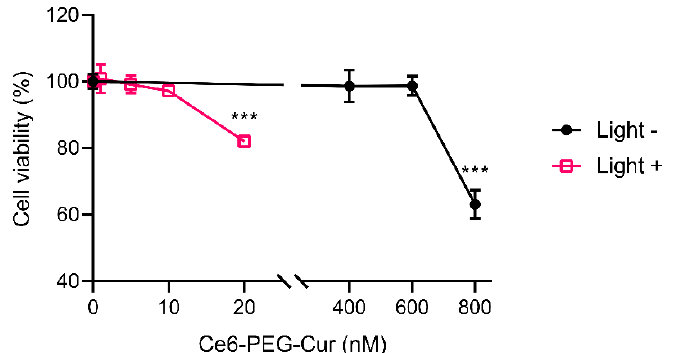
Figure 2. Cell viability of Ce6-PEG-curcumin with and without LED irradiation, measured by MTT assay. Results are expressed as mean ± SD. *** p < 0.001 vs. control.